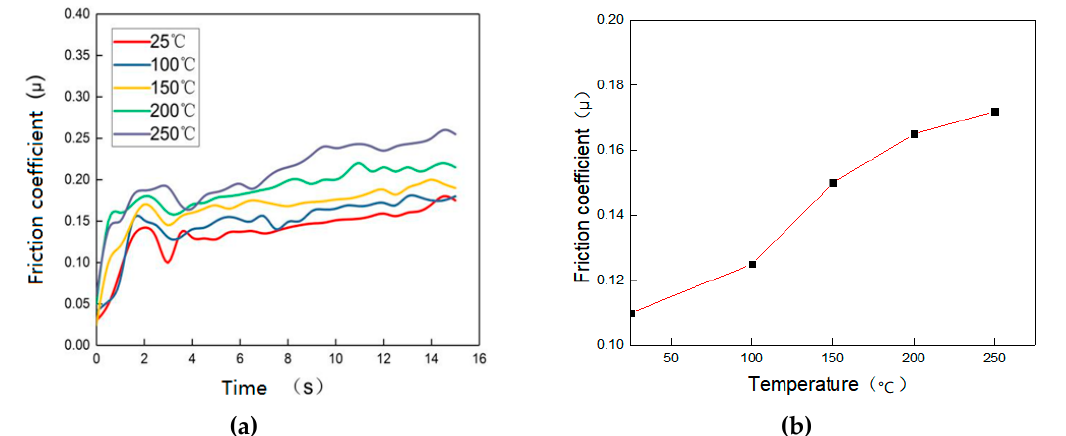
Figure 3. The fluctuation curve of the friction coefficient with sliding stroke in boundary lubrication: ( a ) Variation curves of the friction coefficient with time under different temperatures; ( b ) Experimental friction coefficients at different temperatures.